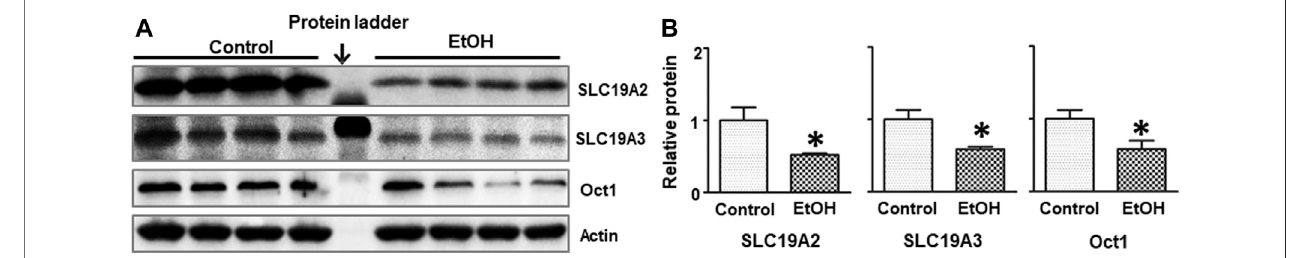
FIGURE 7 | Effects of chronic alcohol exposure on the expression of thiamine transporters in the brain. (A) The expression of thiamine transporters (SLC19A2, SLC19A3, and OCT1) in the cerebrum was determined by IB. (B) The relative amounts of expression were quanti fi ed and normalized to the expression of actin. The results were expressed as the mean ± SEM, n (cid:2) 4 for each group. * p < 0.05 denotes a statistically signi fi cant difference from the control group.